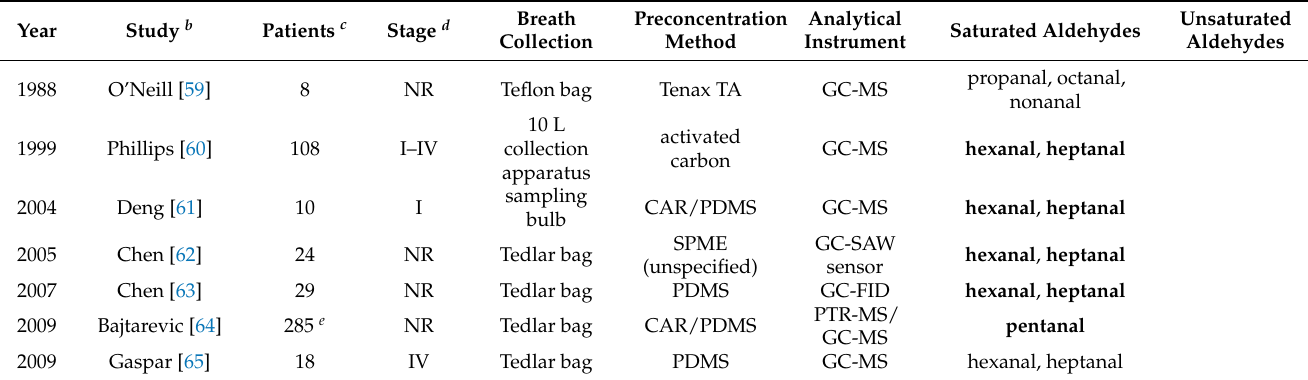
Table 3. Study details and exhaled aldehydes reported in breath analysis articles reviewed a